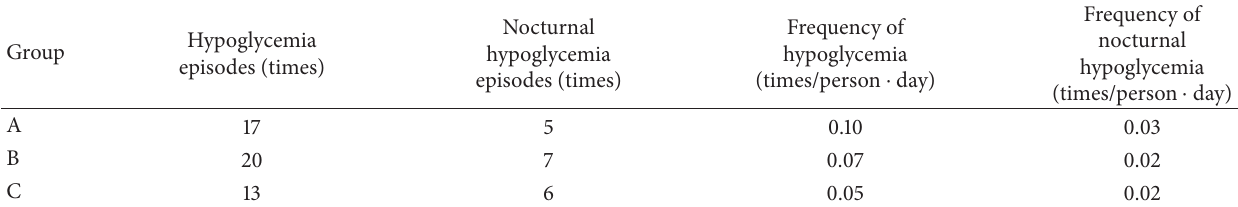
Table 5: Comparison of hypoglycemia and nocturnal hypoglycemia